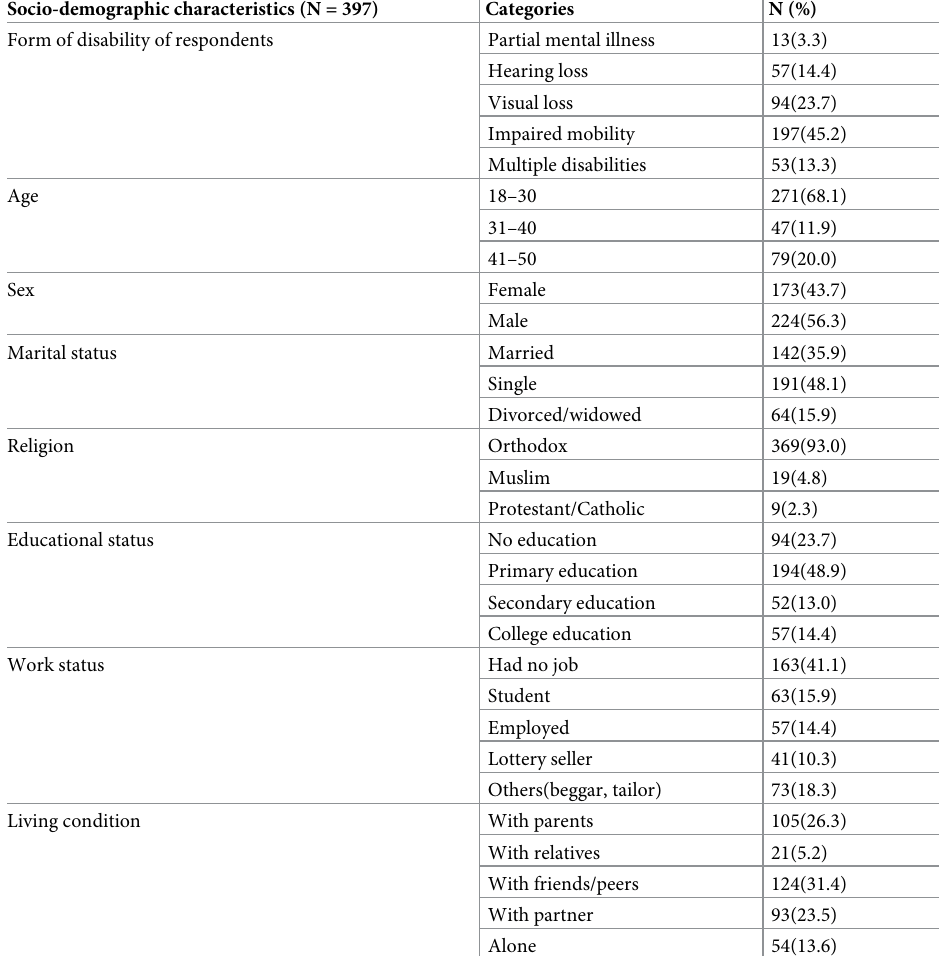
Table 2. Sociodemographic characteristics of respondents in North-shewa zone, Ethiopia, 2019. Socio-demographic characteristics (N =